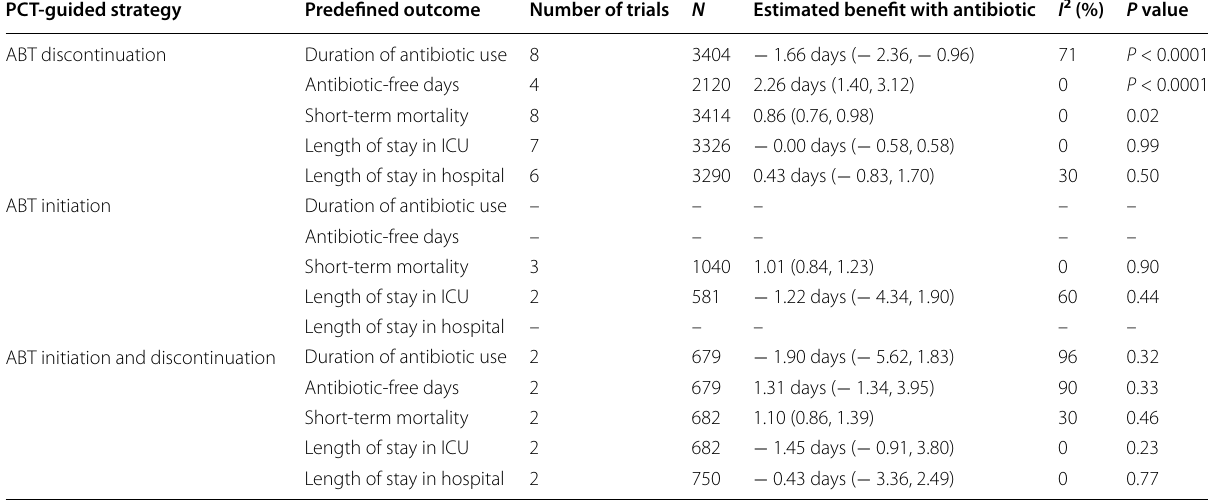
Table 2 Summary of findings for the effect of procalcitonin-guided strategy on predefined outcomes in intensive care unit